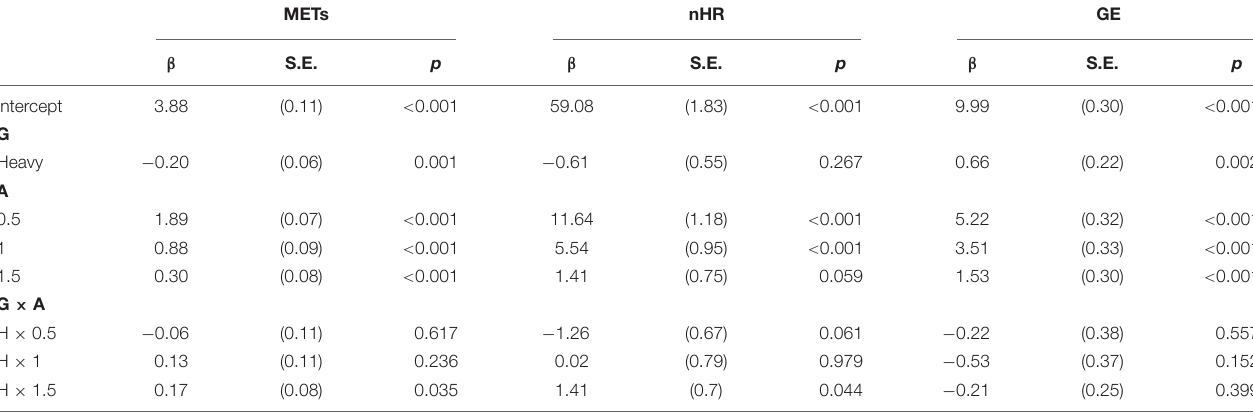
The condition with light gear ratio (G) and assistive level (A) of 2 served as reference. TABLE 2 | Coefficients ( β ), standard errors (S.E.) and p values of physiological responses in 2.5% slope conditions. METs